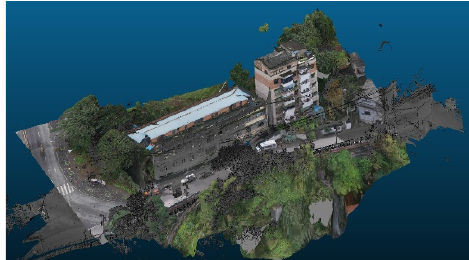
Figure 4 . Fusion result by spatio-temporal-spectral-angular